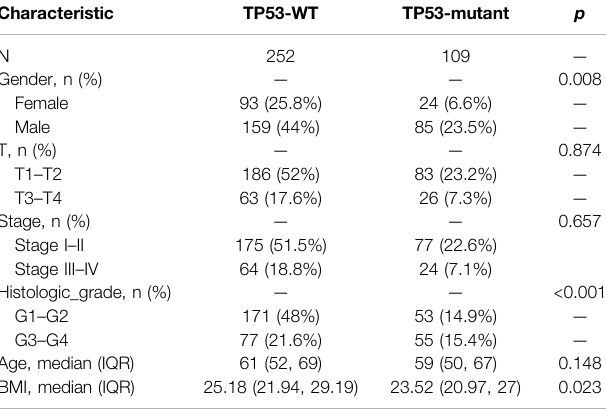
TABLE 4 | Baseline data.